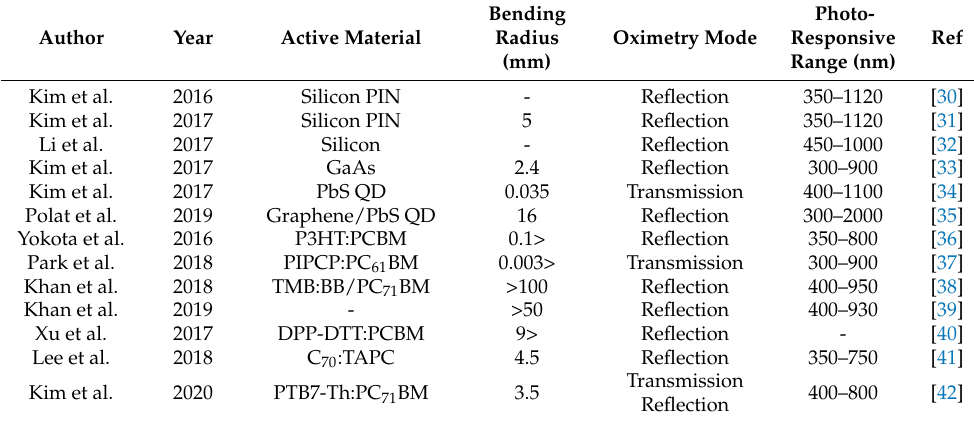
Table 1. State-of-art skin-compatible and wearable photoplethysmography (PPG)